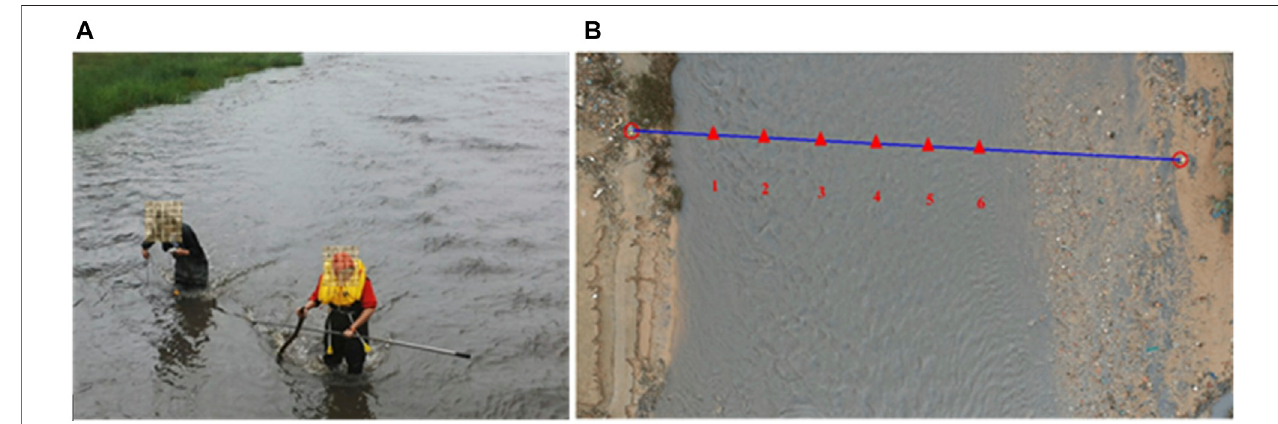
FIGURE 10 | Manual measurement by propeller fl ow meter. (A) Scene of manual measurement. Two people cooperate to determine the points to be measured, one of whom holds a propeller fl ow meter to measure the surface velocity. (B) Cross-section and measurement positions. The red triangles 1 – 6 represent the measurement positions 1.2, 2.4, 3.6, 4.8, 6, and 7.2 m away from the right bank of the river, respectively.